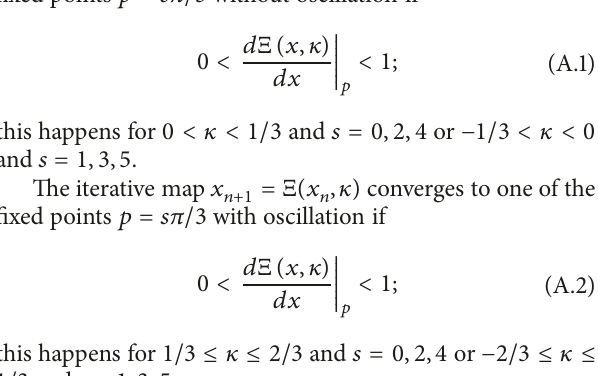
The iterative map 𝑥 𝑛+1 = Ξ(𝑥 𝑛 , 𝜅) converges to one of